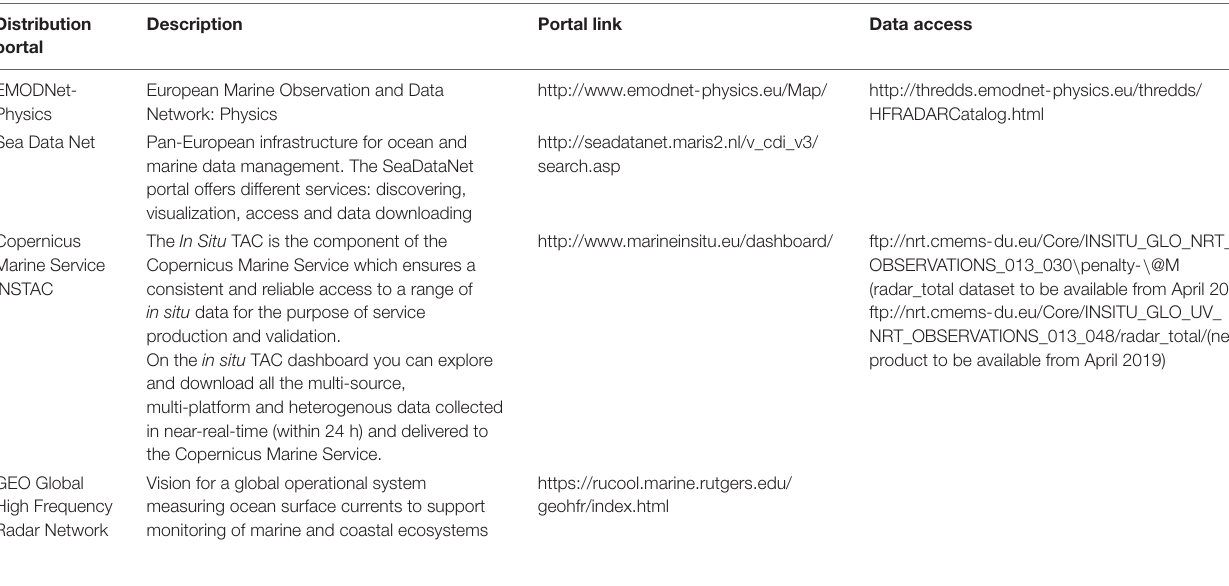
TABLE 11 | European and global marine data distribution portals served by the EU HFR